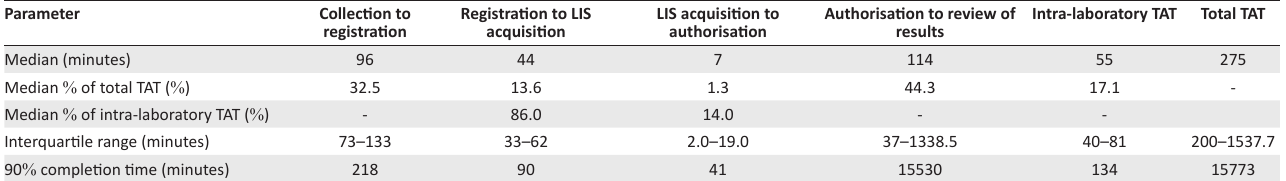
TABLE 2: Summary of turn-around times across phases of workflow for 1176 full blood count requests from the haematology outpatient department at Tygerberg Academic Hospital in Cape Town, South Africa, over the period February 2018 to April 2018. Parameter